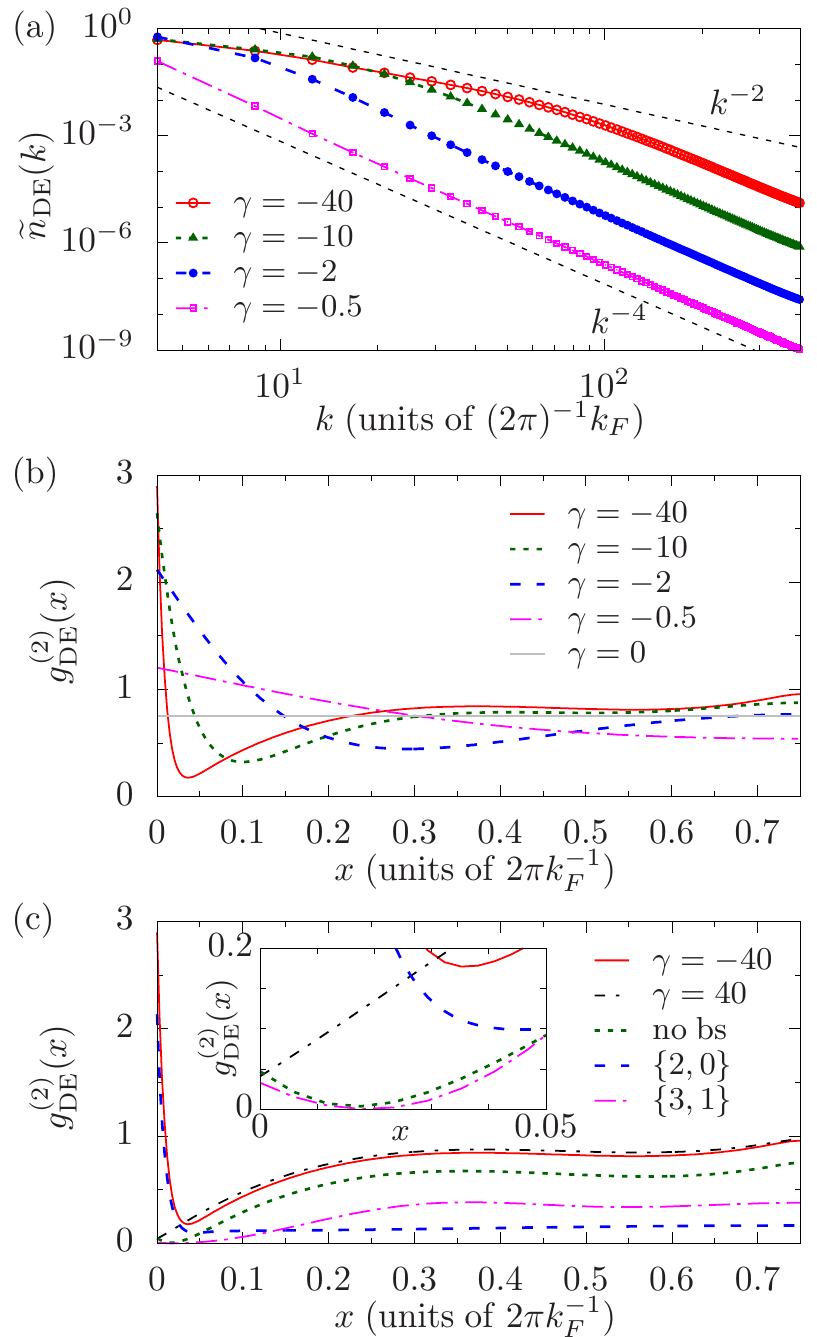
Figure 11: Diagonal-ensemble correlation functions for quenches to γ = − 0.5, − 2, − 10, and − 40 for N = 4 particles. (a) Momentum distribution dicate scalings ∝ k − 2 (upper line) and ∝ k − 4 (lower line). (b) Second-order correlation ( 2 ) ( x ) . The grey horizontal line indicates the initial value g ( 2 ) ( x , t = 0 ) . (c) Matrix ele- g DE }| ˆ g ( 2 ) ( x ) |{ λ }〉 of the second-order correlation in representative eigenstates. The ments 〈{ λ j j inset shows these correlations at small separations x , with the result for the super-Tonks state { n } = { 3,1 } (pink dot-dashed line) scaled by a factor of 10 for visibility. j